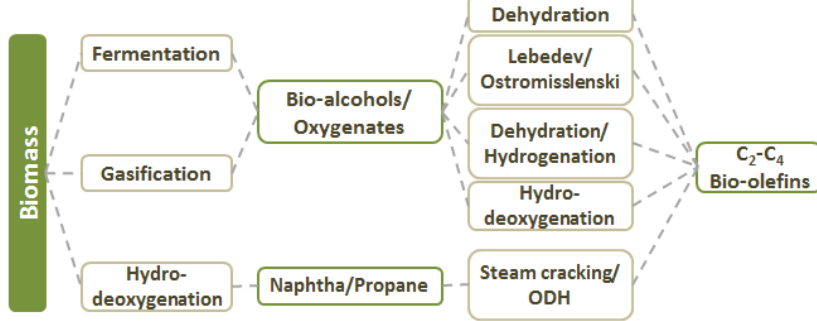
Figure 5. Biomass to olefins primary routes.